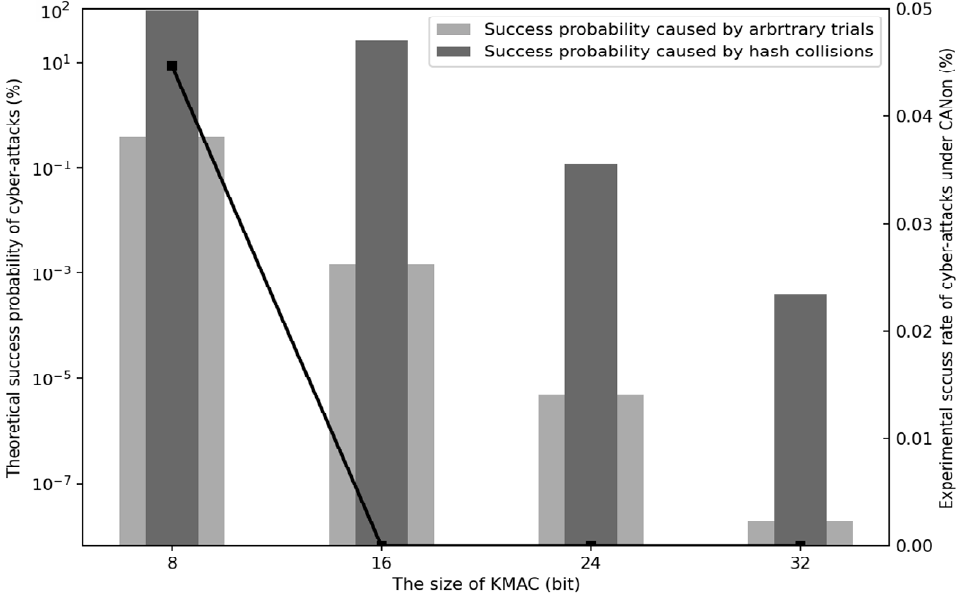
Figure 9. Comparison of the cyber-attack success rate between the theoretical analysis and the experiment as a function of the size of KMAC.